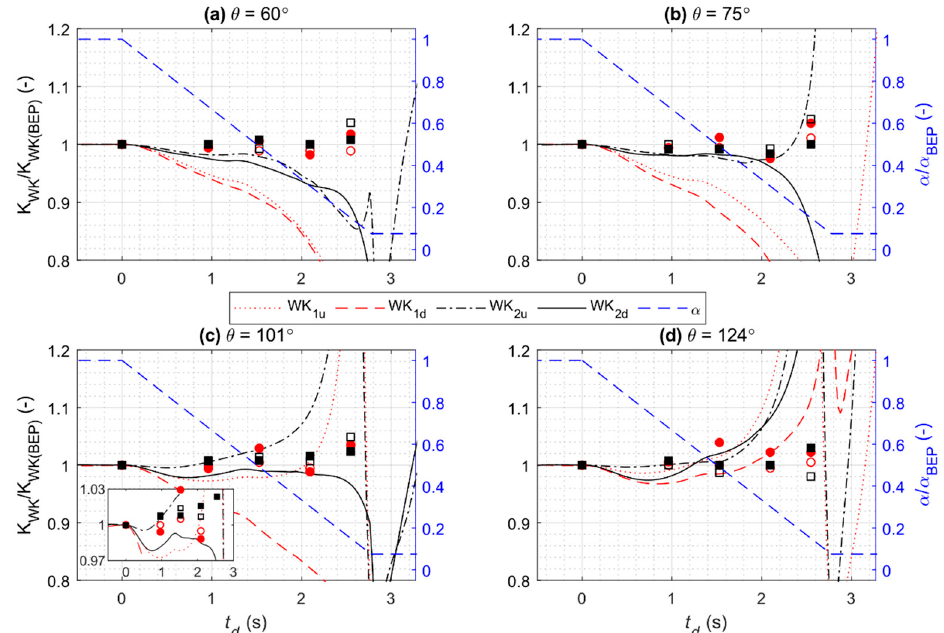
Figure 10. Variation of the WK coe ffi cients over time during deceleration at four di ff erent azimuthal locations ( θ ) of the SC. Steady WK coe ffi cients obtained at five GVAs ( α ) are represented by the symbols: , WK1u; • , WK1d; (cid:3) , WK2u, (cid:4) , WK2d. The WK coe ffi cients were calculated from Equation (1) with n = 0.5 and the absolute value of ∆ P , i.e., K | ∆ P | —as negative values of ∆ P s for some WKs = Q / (cid:35) WK were observed towards the end of the deceleration. Q and ∆ P are instantaneous flow rate and pressure di ff erence, respectively during